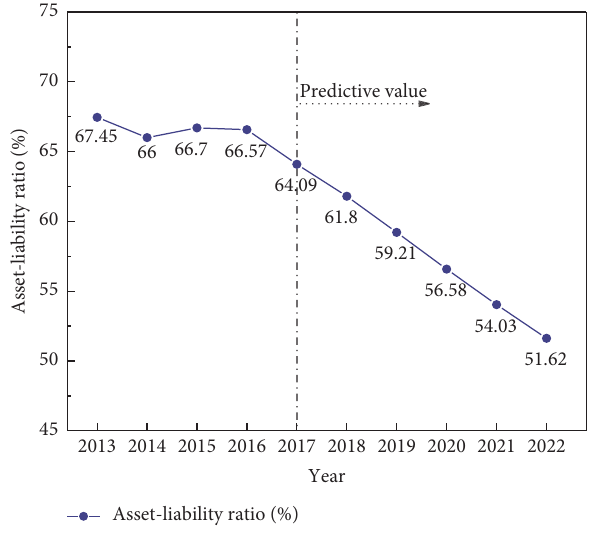
Figure 5: Trend of asset-liability ratio